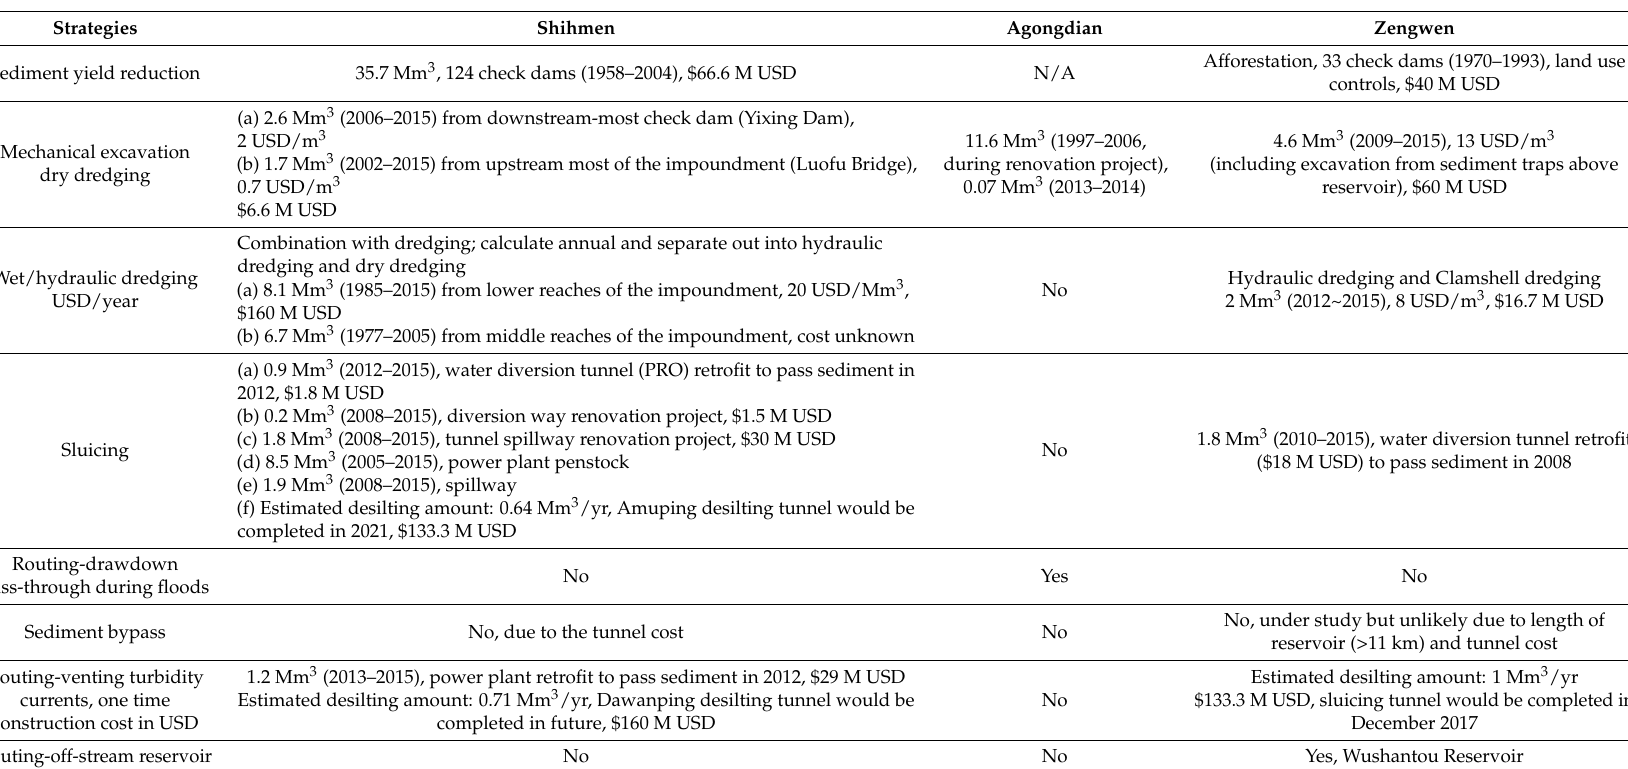
Table 4. Summary of sediment management strategies at three case studies. Data are from WRA [26–34]. Strategies Shihmen